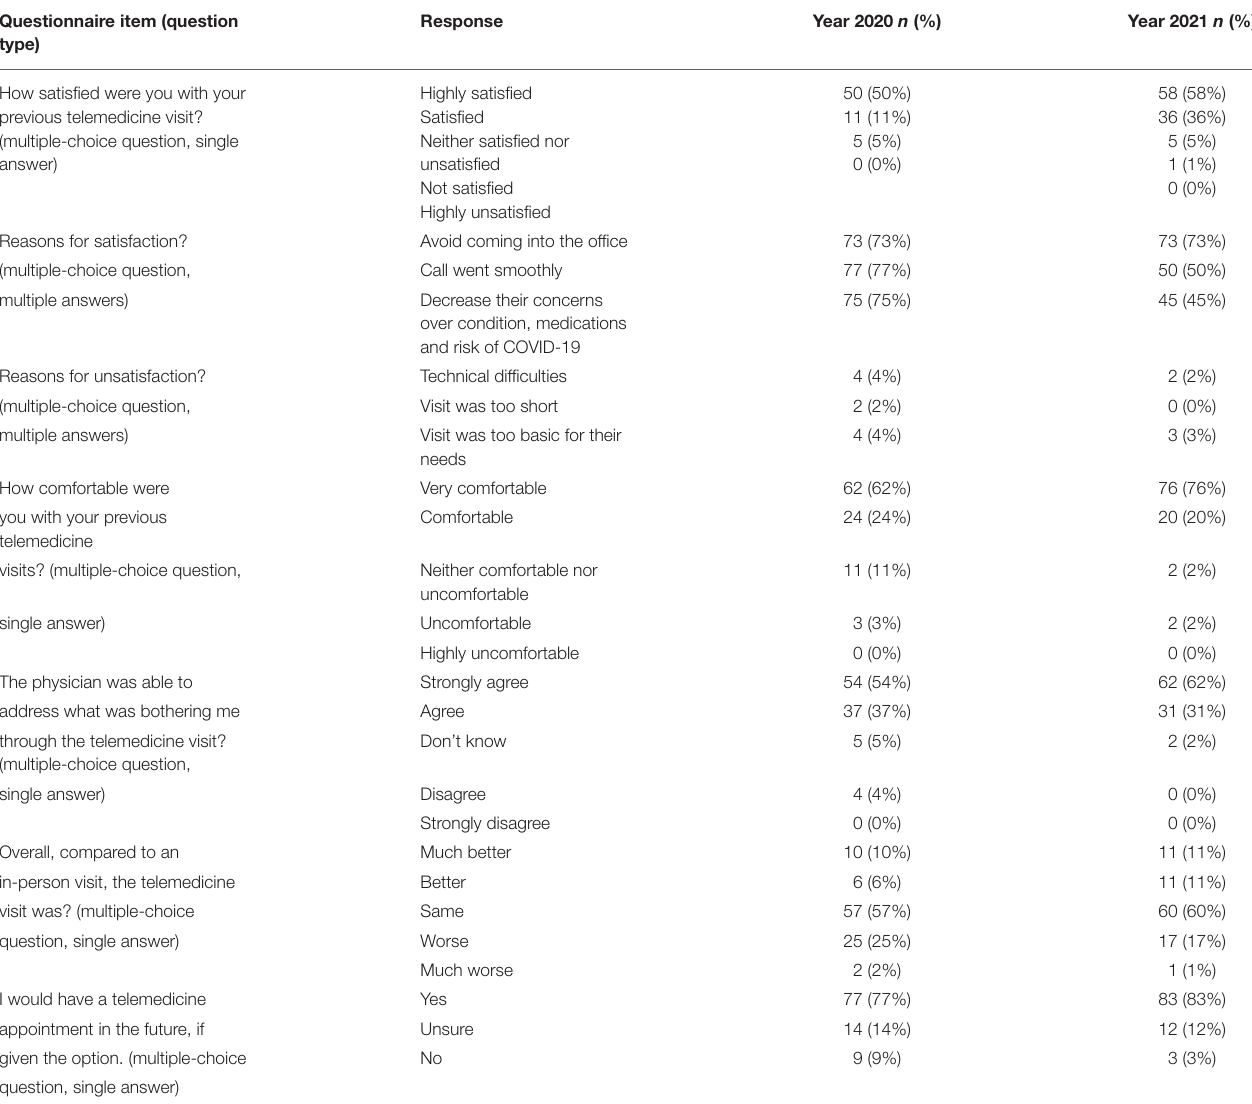
TABLE 2 | Telemedicine